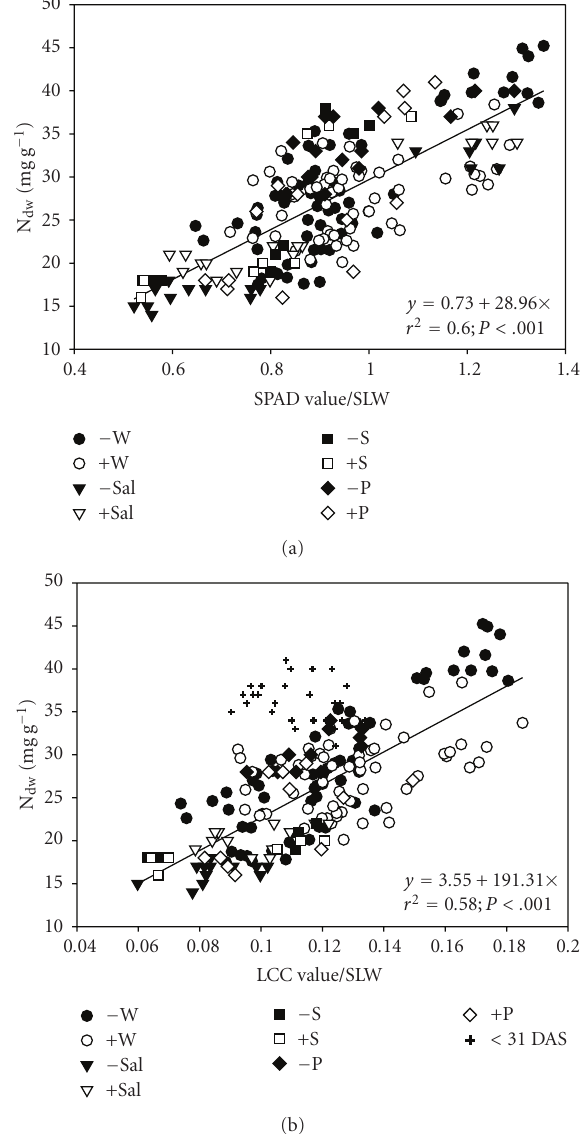
Figure 2: Leaf N concentration based on dry weight (N dw ) versus (a) chlorophyll meter (SPAD) and (b) leaf color chart (LCC) values, both adjusted for specific leaf weight (SLW). Data from all samplings and treatments ( n = 210) were used for the linear regression in (a) whereas value pairs from measurements at very early crop growth stages ( ≤ 31 DAS) in (b) were not